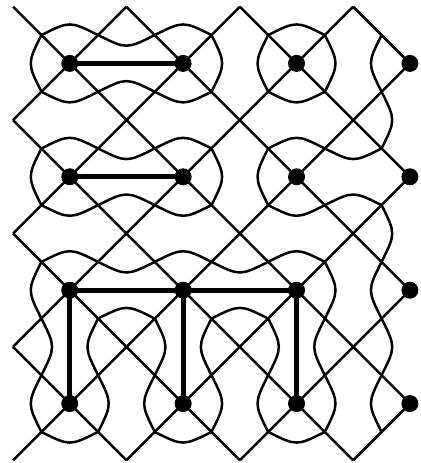
in this example. An odd 2